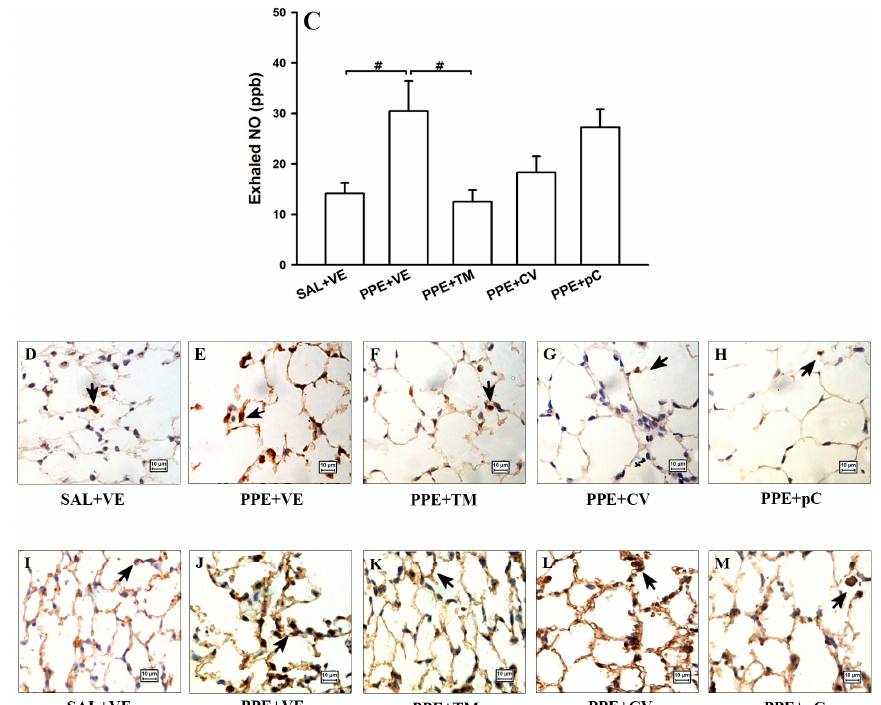
Figure 5. Effects of monoterpenes thymol, carvacrol and p -cymene in the NF- κ B expression in alveolar septa and oxidative stress pathway. Data are presented as mean ± standard error (SE) ( n = 5 to 7 mice/group) of the number of positive cells to NF- κ B ( A ) detected in alveolar septa, the volume proportion of 8-iso-PGF-2 α expression ( B ) detected in alveolar septa and exhaled nitric oxide detected in the exhaled air ( C ) from mice in the day 28 of the protocol. Panels D to H represent tissue stained to detect NF- κ B and panels I to M to detect isoprostane by immunohistochemistry. Arrows represent positive cells in lung tissue. SAL + VE: control group with vehicle treatment; PPE + VE: porcine pancreatic elastase instillation and vehicle treatment; PPE + TM: porcine pancreatic elastase instillation and thymol treatment; PPE + CV: porcine pancreatic elastase instillation and carvacrol treatment; PPE + pC: porcine pancreatic elastase instillation and p -cymene treatment. * p < 0.01, ** p < 0.001 and # p < 0.05.